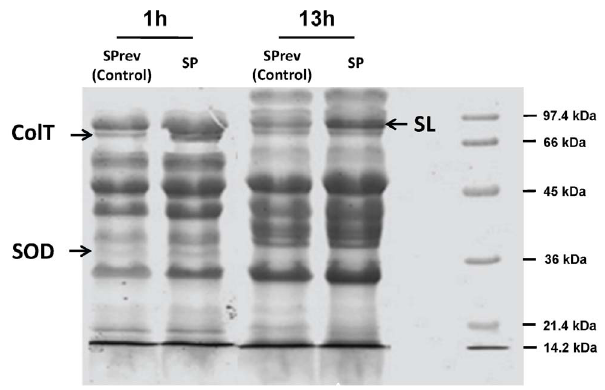
Figure 3. SDS page analysis of secreted Bacillus cereus proteins after 1 or 13 h treatment with Substance P (SP) or Substance P reverse (SPrev) (10 2 6 M). Bacteria exposed for 1 h to SP showed an increase in the production of the collagenase (ColT) and of superoxide dismutase (SOD). Bacteria treated for 13 h with SP presented in contrast an increase in the S-layer crystal protein (SL). Results are representative of three independent experiments. doi:10.1371/journal.pone.0078773.g003 percentage of 59% (15 matched fragments) as the Thermo unstable ribosomal Elongation factor (Ef-Tu) (NCBI number NP_830009, 42912 Da, pI = 4.93).